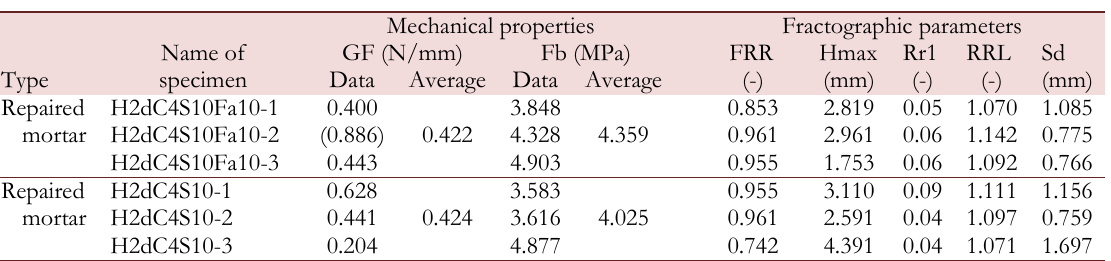
Table3: Mechanical properties of repaired mortar specimens.